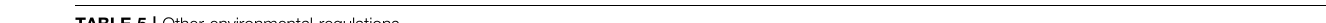
TABLE 5 | Other environmental regulations. Thistablepresentstheresultsafterwecontrolforotherenvironmentalpolicies.ERisadoptedtomeasuretheoveralllevelsofChineseenvironmentalregulationduringour sample periods, which equals to the ratio of GDP on energy (in terms of ten thousand RMB/ton of standard coal equivalent). Higher ER value represents more stringent environmental regulation. In this table, we do not control for year fi xed effect, as there is a multicollinearity issue between year fi xed effect and ER. For the probit regression (column Distress), we report the marginal effect rather than the coef fi cients. For the de fi nitions of variables refer to Appendix A . P -values are in